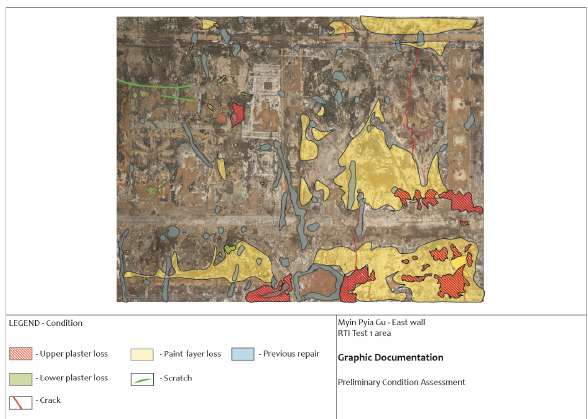
Figure 8. Condition assessment from